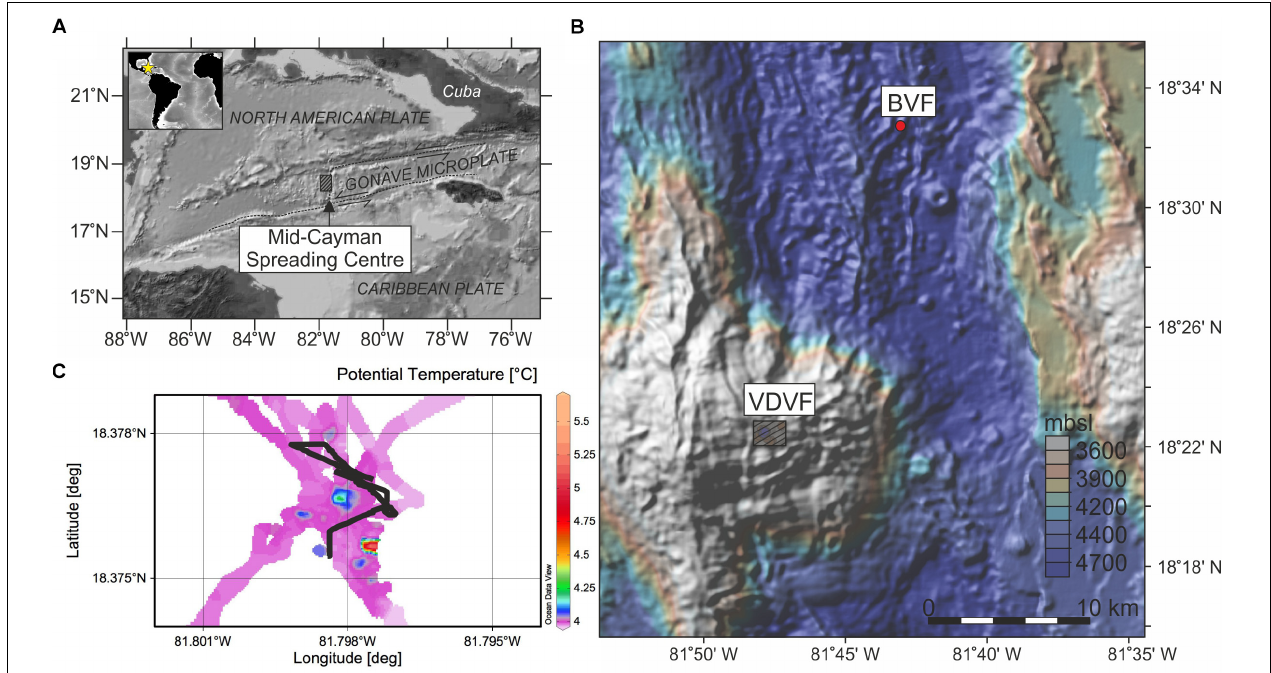
FIGURE 1 | Location of the Mid-Cayman spreading centre (MCSC) (A) and bathymetry map of the Mid Cayman Rise (B) showing the positions of the VDVF (box; this study) and BVF (red circle). Color scale in (B) represents meters below sea level (mbsl). Seafloor temperature map over the VDVF using data from a temperature sensor on the ROV Isis, created using Ocean Data View (Schiltzer, 2017) (C) showing the extent of active venting with the tow-yo track of the Niskin rosette (black line). Box in (A) represents location of (B) , box in (B) represents extent of survey area shown in (C)